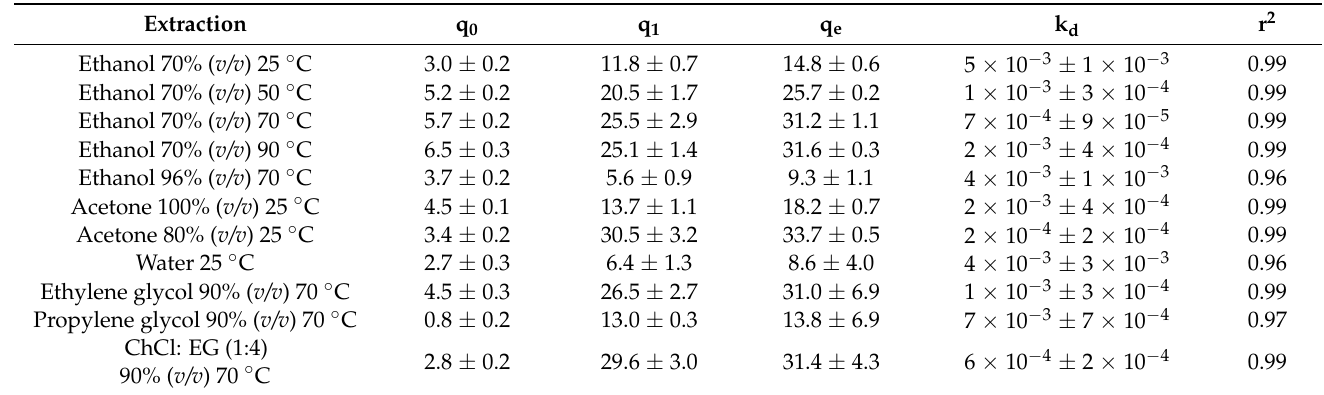
Table 2. Kinetic parameters from the extraction process of AP measuring antioxidant capacity by DPPH method; q 0 , q 1 , and q e are measured in TEAC/gds, while k d units are gds/(TEAC · min).